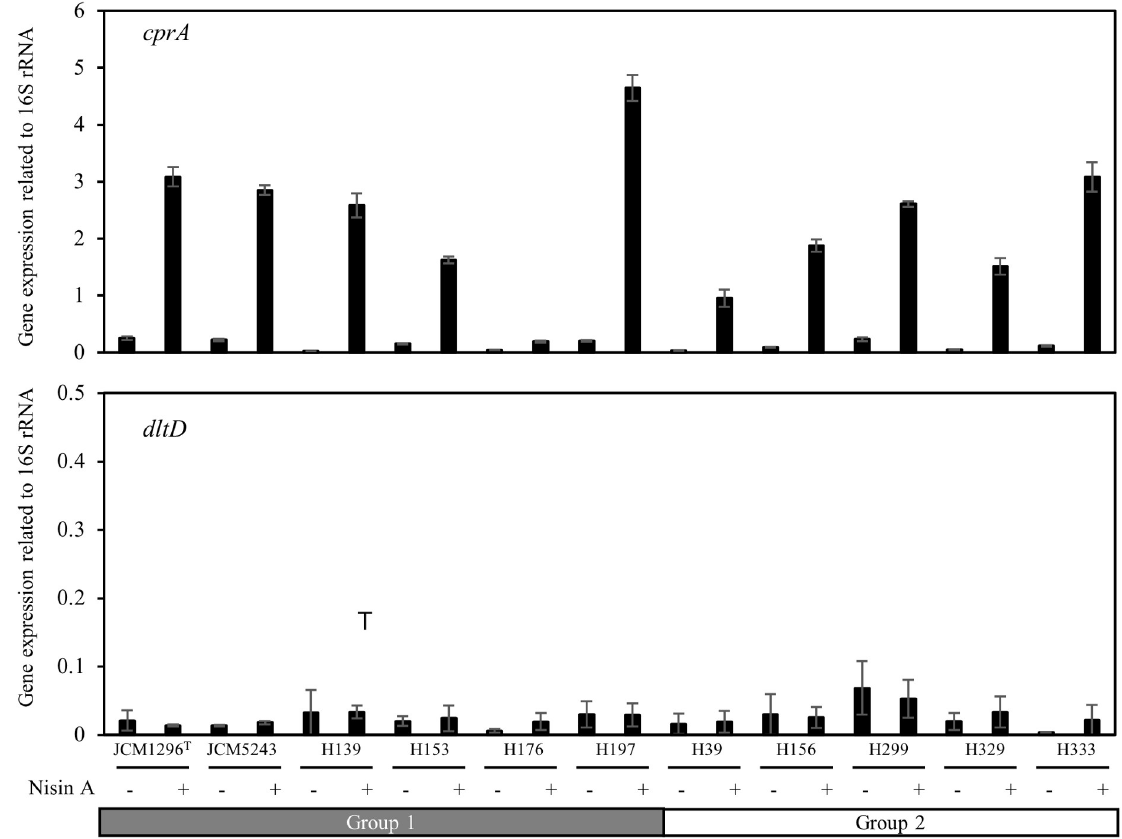
Fig 5. cprA and dltD expression among the 11 C . difficile strains. cprA and dltD expression in 11 C . difficile strains with or without nisin A treatment was investigated. Total RNA was extracted from cells in the exponential phase. After cDNA synthesis, quantitative PCR was performed by using specific primers for cprA and dltD . 16S rRNA was used as an internal control.